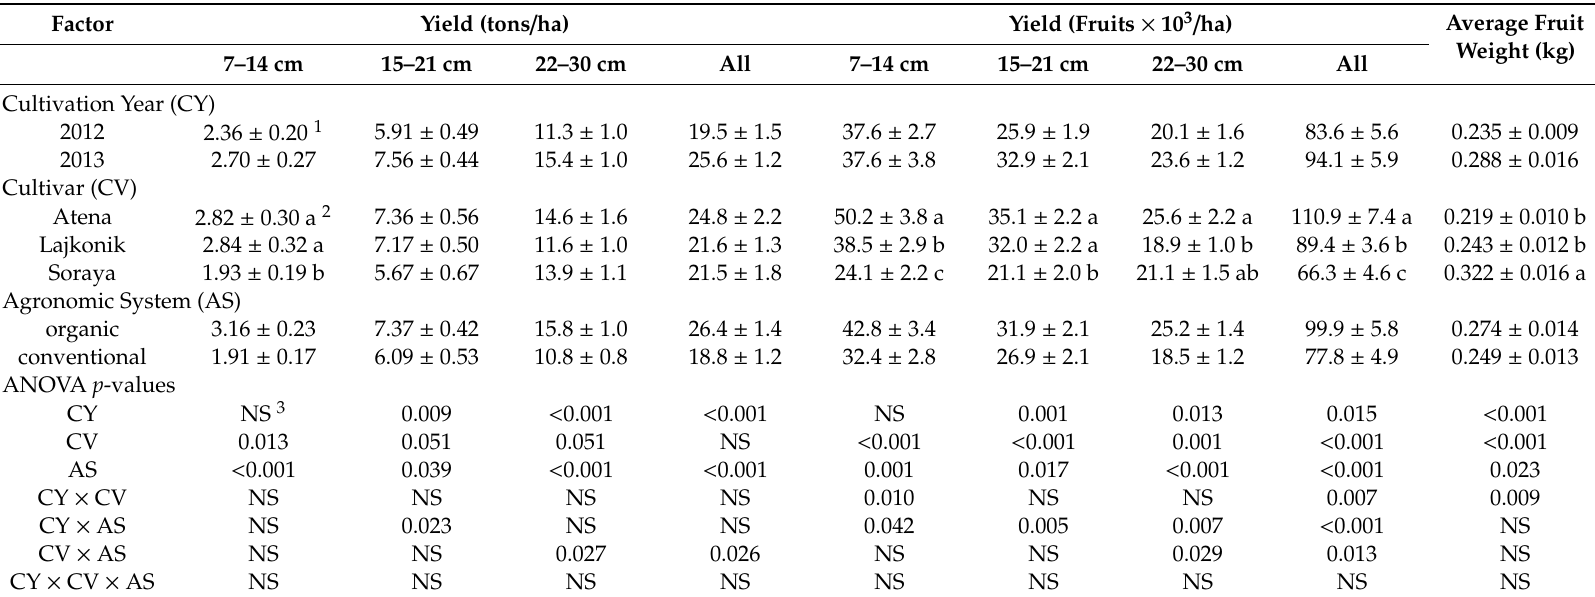
Table 2. The main e ff ects of, and interactions between, cultivation year, cultivar and agronomic system on the yield of small (7–14 cm), medium (15–21 cm) and large (22–30 cm) courgette fruits and the average fruit